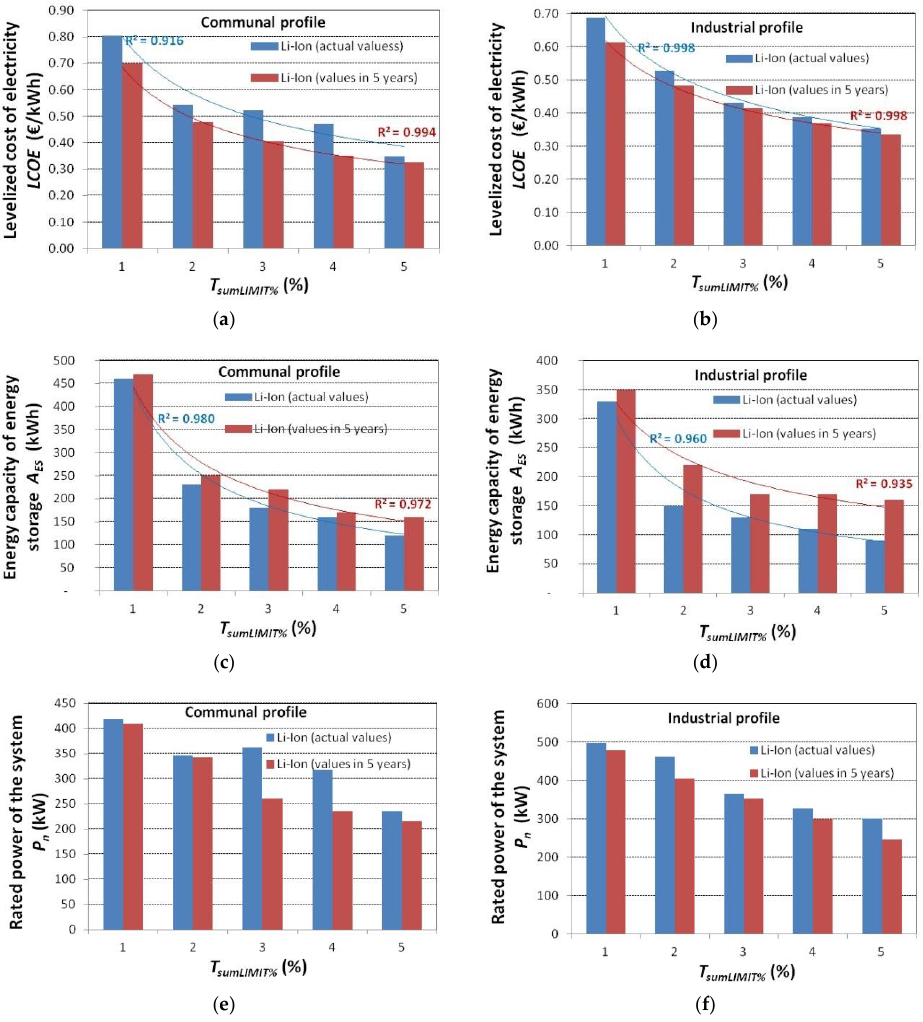
Figure 13. Changes in selected parameters of the optimized systems with no limit for power P n in the function of time T sumLIMIT% for lithium-ion batteries with the current and future (five years’ perspective) engineering and economic parameters: the unit cost of generating energy ( LCOE ) consumed for supplying a communal load ( a ) and industrial load ( b ); energy capacity of a battery pack for a communal load ( c ) and industrial load ( d ); rated power of the power generation system P n for a communal load ( e ) and industrial load ( f ).